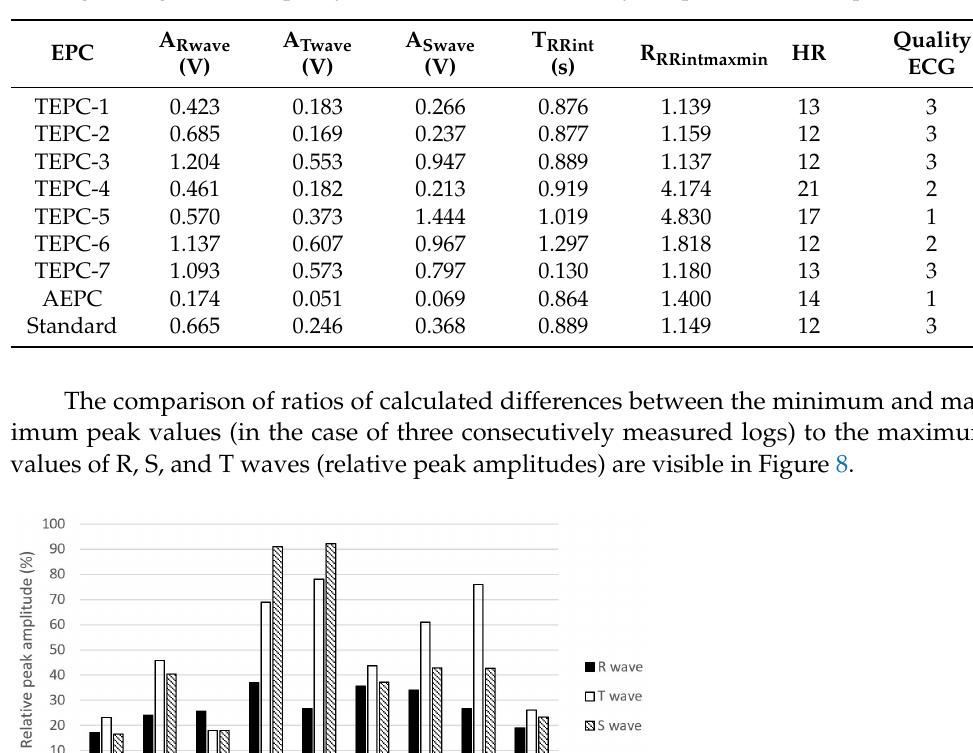
Table 1. Numerical results of feature extraction. The values of pre-selected features of the measured ECG signals together with quality estimation (1—conditionally acceptable; 2, 3—acceptable).